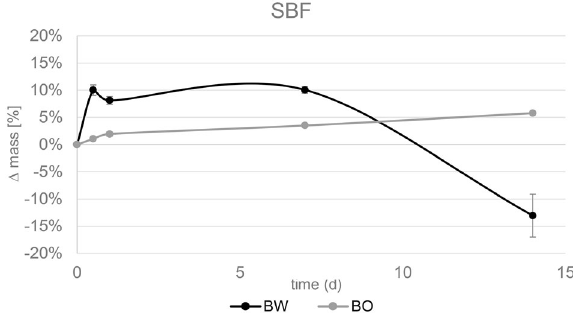
Fig. 6 Relative mass change of bone graft materials BW and BO after storage in simulated body fl uid (SBF) for the respective time